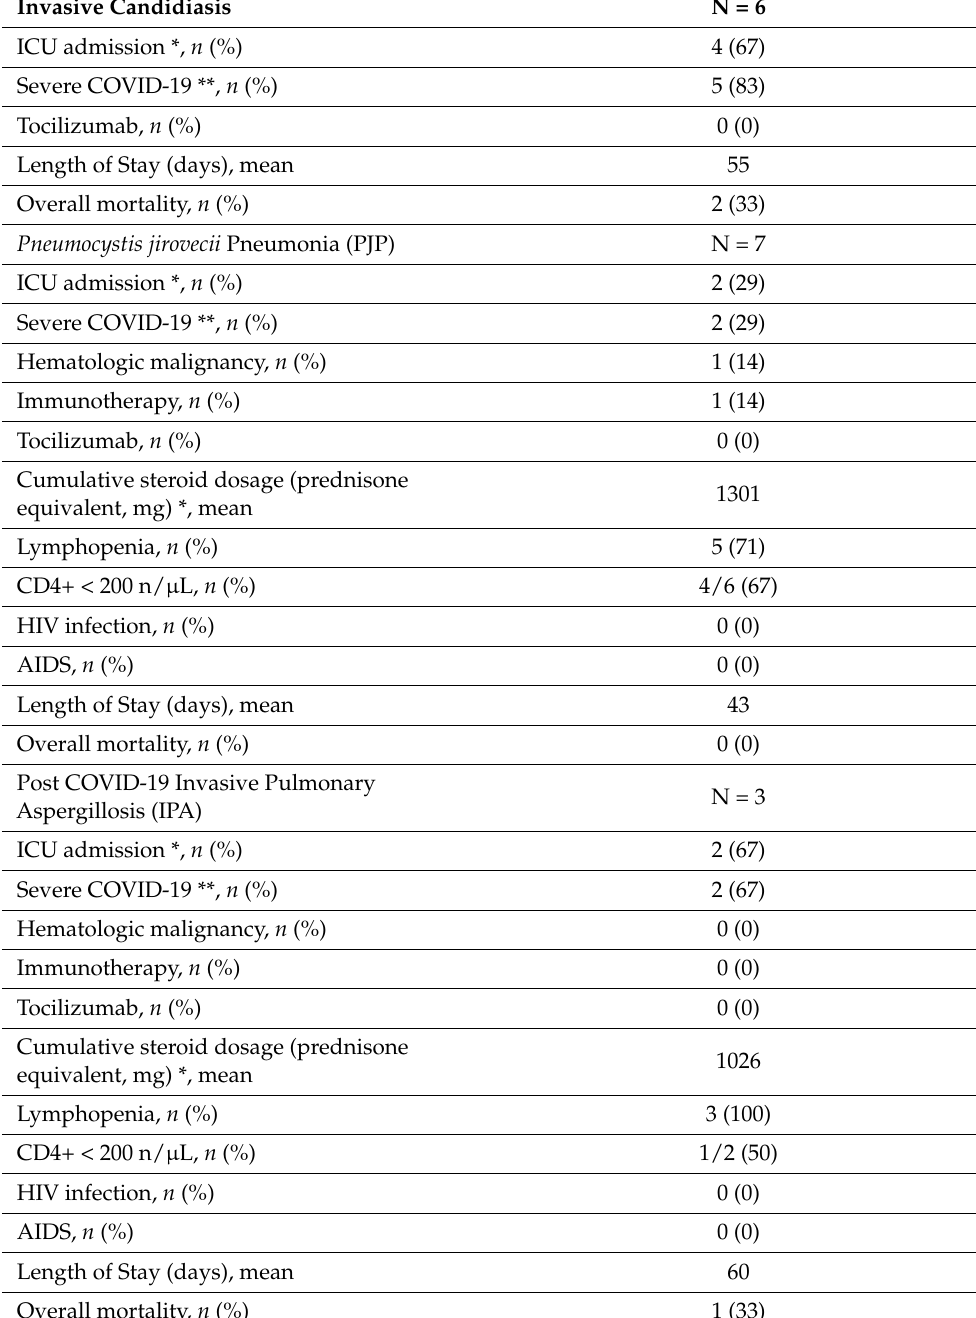
Table 3. Characteristics of COVID-19 patients who developed IFIs clustered by fungus genera. Invasive